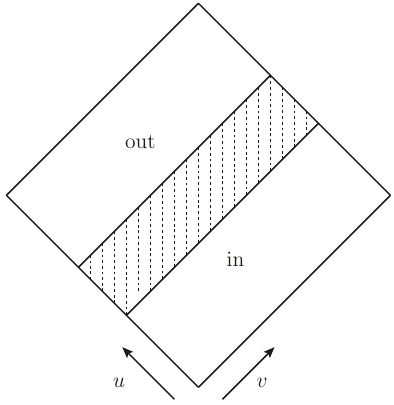
Figure 1 . A two dimensional Penrose diagram of a sandwich plane wave, ignoring the spatial directions. While the far past and future are (cid:13)at, the grey region de(cid:12)ned by u 1 (cid:20) u (cid:20) u 2 has non-vanishing